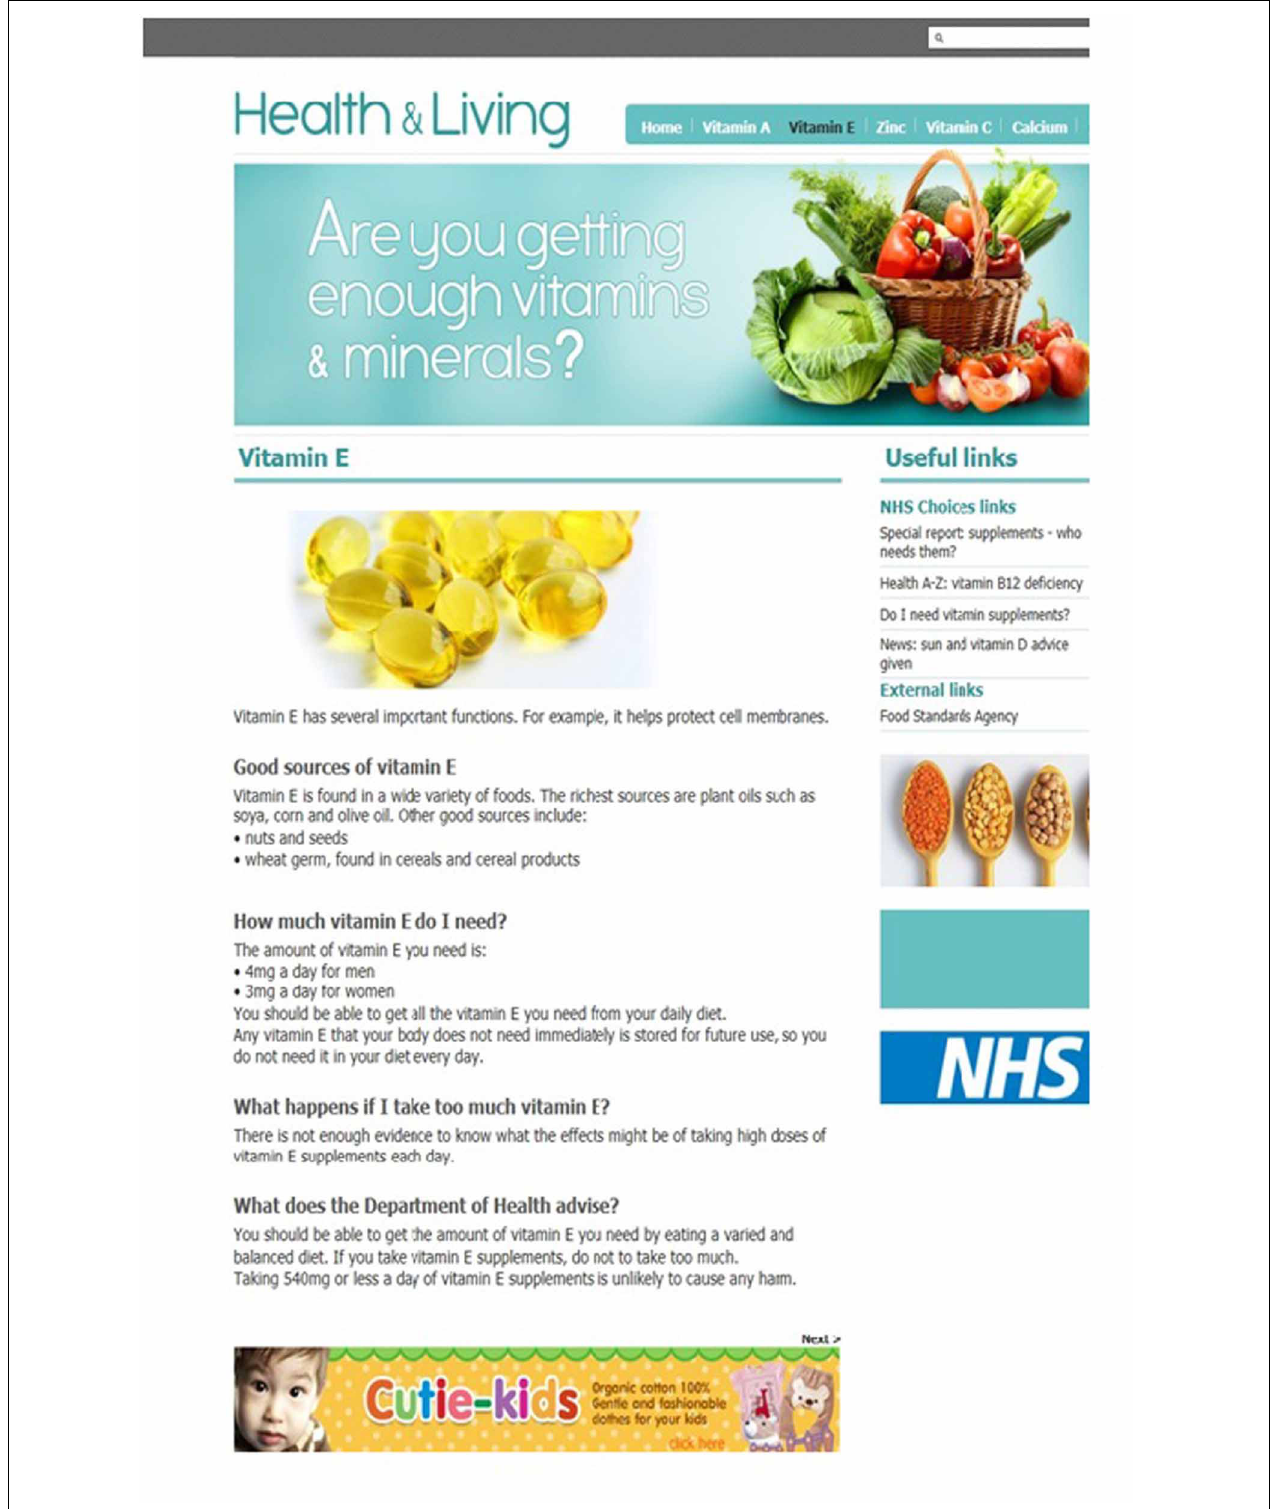
FIGURE 2 | An example webpage used in the experiment that presented information about Vitamin E along with useful links and a horizontal banner advertisement (located bottom-center).